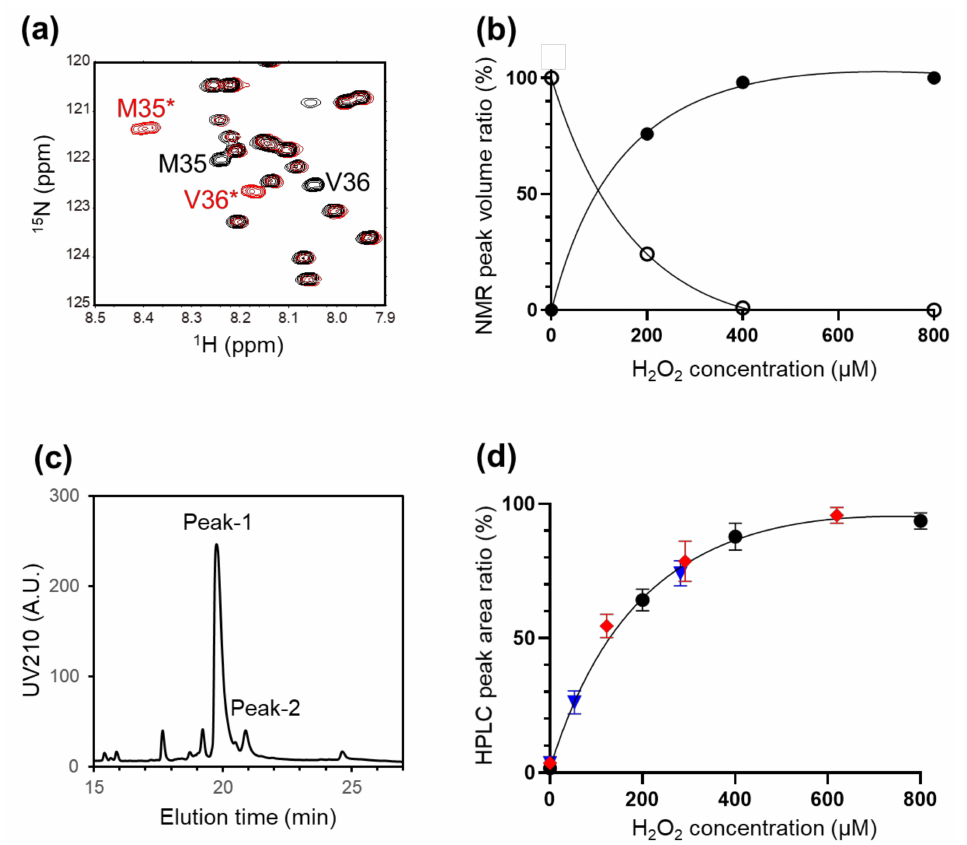
Figure 6. ( a ) The portions of 1 H– 15 N HSQC spectra of A β (1–40) in the absence (black) and presence (red) of 800 µ M H 2 O 2 . The spectrum of A β (1–40) was measured at 24 h after H 2 O 2 treatment. ( b ) Changes in the NMR peak volume ratio of Met35 ( 1 H 8.2 ppm, 15 N 122.0 ppm, open circle) and Met35* ( 1 H 8.4 ppm, 15 N 121.4 ppm, closed circle) of A β (1–40) depending on the H 2 O 2 concentration. ( c ) HPLC profiles of A β (1–40) treated with 800 µ M H 2 O 2 . ( d ) Changes in the HPLC peak area ratio of peak-1 to peak-2 depending on the H 2 O 2 concentration. HPLC peak area ratios were plotted as a function of the H 2 O 2 concentration used for the A β (1–40) treatment (black circle) along with those from the CAP irradiation experiments. For plotting, the CAP irradiation period was converted into the concentration of H 2 O 2 generated in the buffer solution pretreated with CAP using 8.0 W and 1.0 W plasma jet apparatuses (according to the results shown in Figure S4 (red rhombus) and Figure S5 (blue triangle), respectively). Each ratio value is the mean ± SD of three